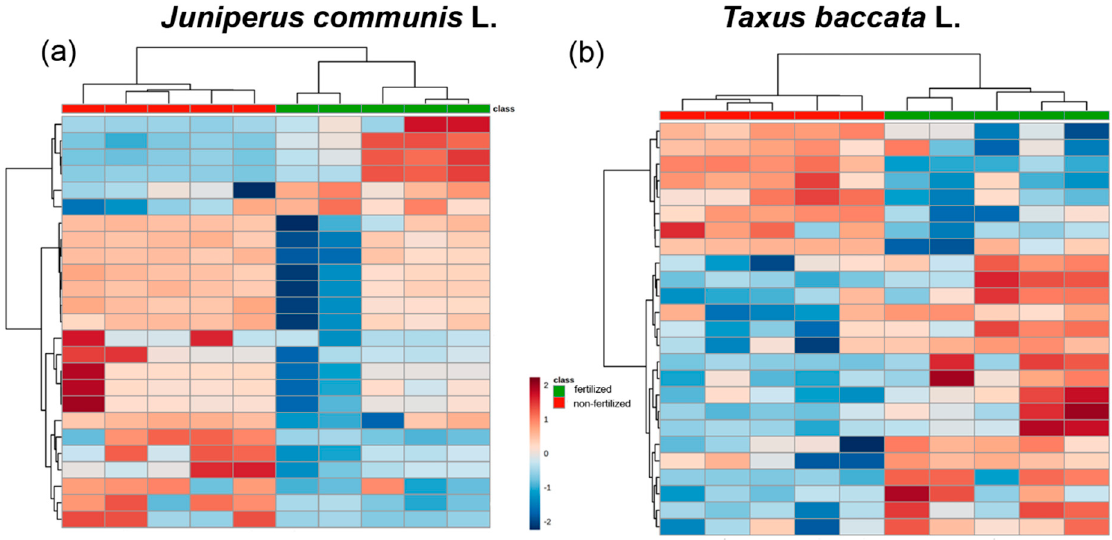
Figure 5. Results of ( a ) Juniperus communis L. and ( b ) Taxus baccata L. pollen grain metabolomes collected from analysis of long-term-fertilized (green) and non-fertilized (red) male plants with hierarchical clustering in the form of heat map prepared with measured Euclidean distance and ward.D clustering algorithm. The colored boxes indicate the relative concentration of the corre- sponding metabolite in each analyzed sample, where red and blue symbolize higher and lower values, respectively.